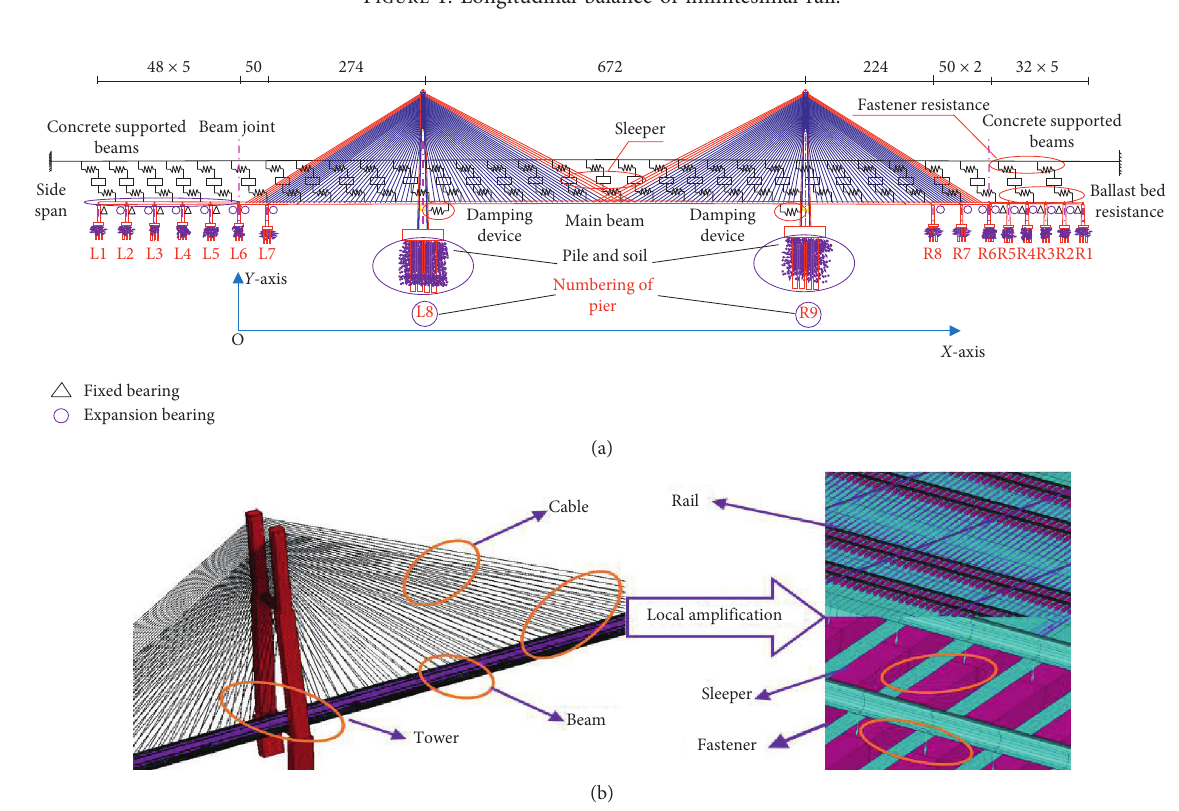
Figure 2: Track-beam-cable-tower spatial model. (a) Global image of the track-bridge (unit: m). (b) Bridge and track